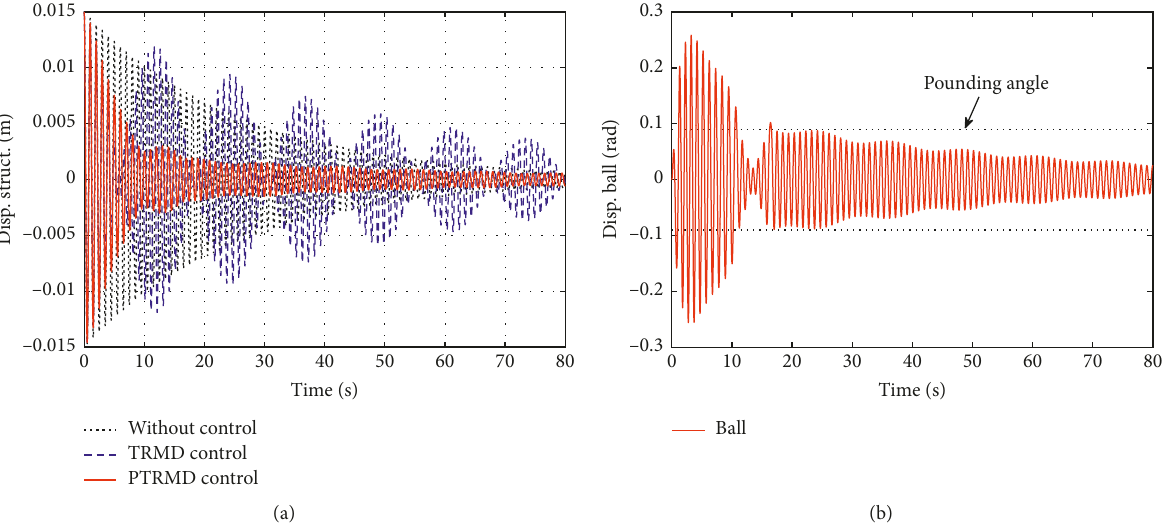
Figure 12: Displacement response of (a) the uncontrolled or TRMD-/PTRMD-controlled structure and (b) the oscillator when the structure subject to an initial